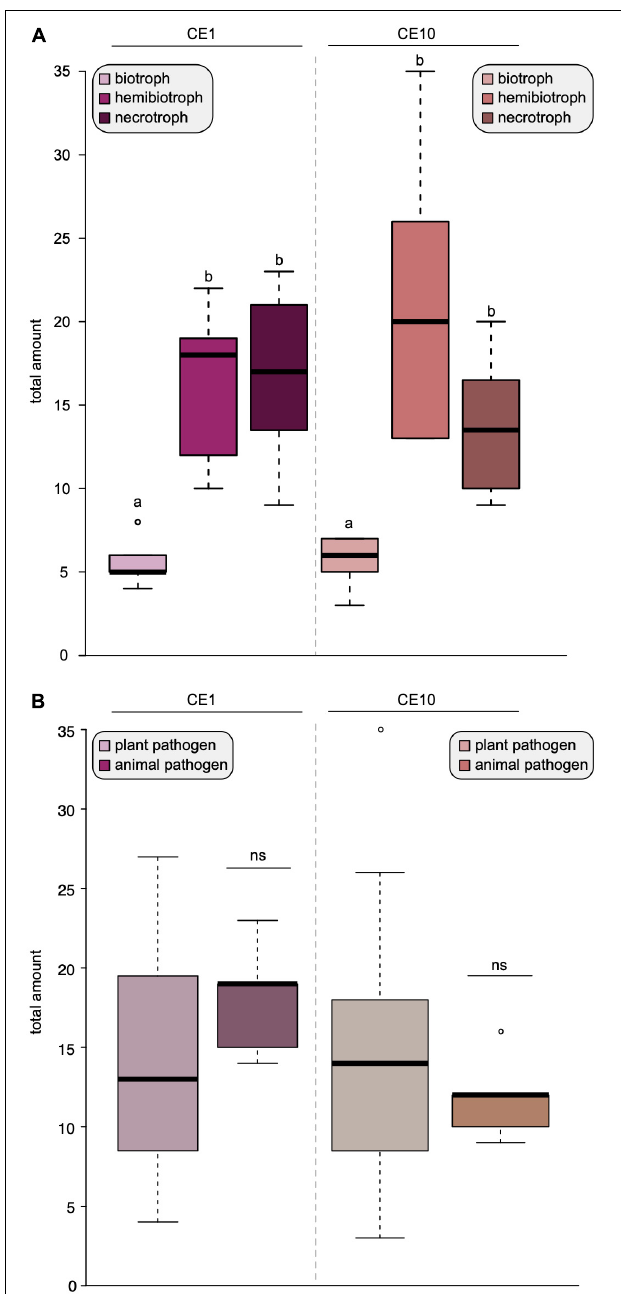
FIGURE 2 | Lifestyles shape the distribution of carbohydrate esterases 1 (CE1) and 10 (CE10) in oomycetes. Box plots of the number of CE1- and CE10-coding genes found in 25 oomycete genomes. (A) The coding capacity for CE1 and CE10 sorted by lifestyles. (B) The coding capacity for CE1 and CE10 sorted by host type, i.e., whether the oomycete pathogens infect plants or animals. Significant differences ( p < 0.05) are indicated by different letters, ns, not